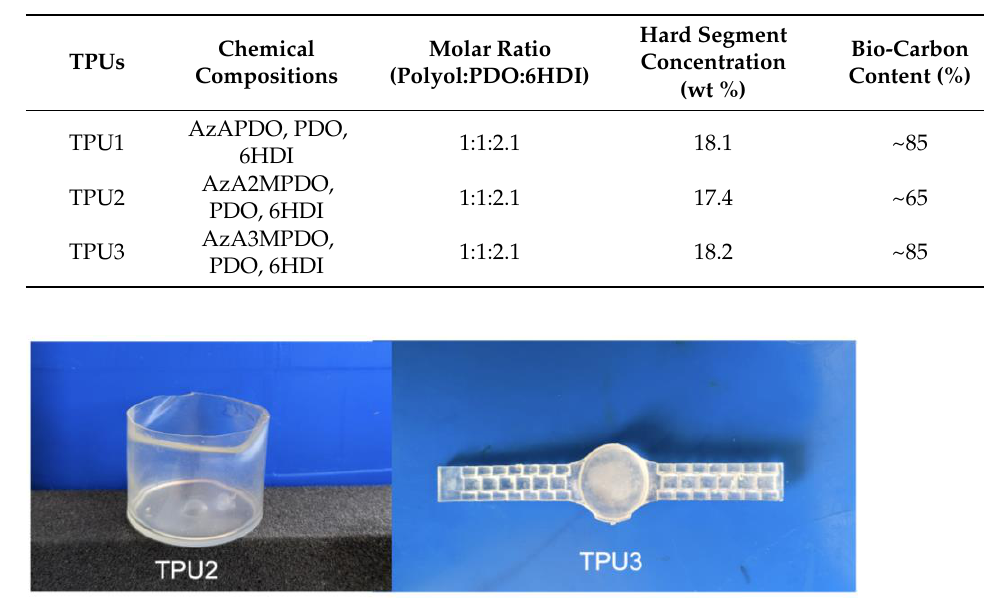
Table 3. Designations, chemical compositions, the molar ratio of monomers used in the preparation of TPUs, and percent bio-carbon content for TPUs.